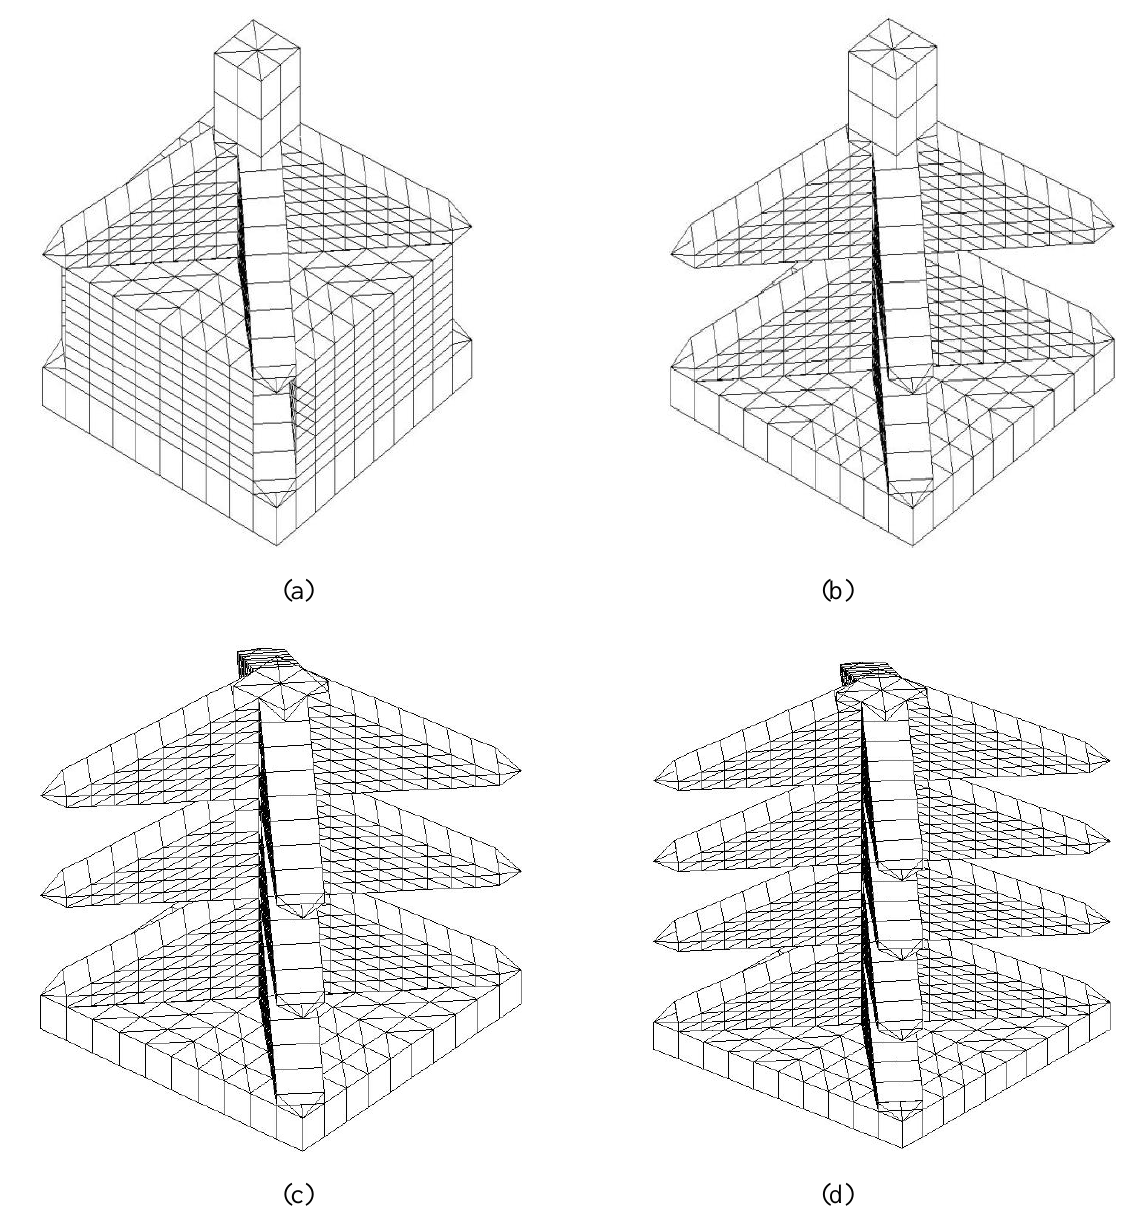
Figure 9. Complex footing forms based on finite element modeling for (a) with four foothills, for (b) with eight foothills, for (c) with twelve foothills and for (d) with sixteen